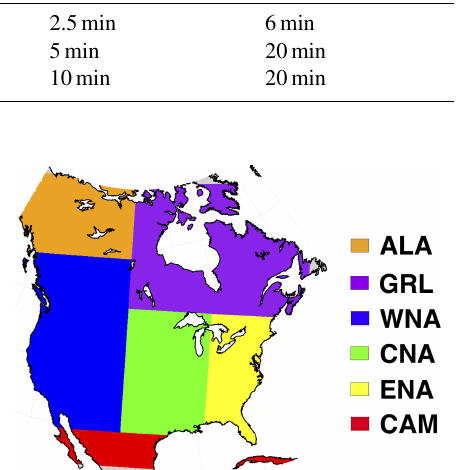
Central America, CAM; western North America, WNA; cen- tral North America, CNA; eastern North America,